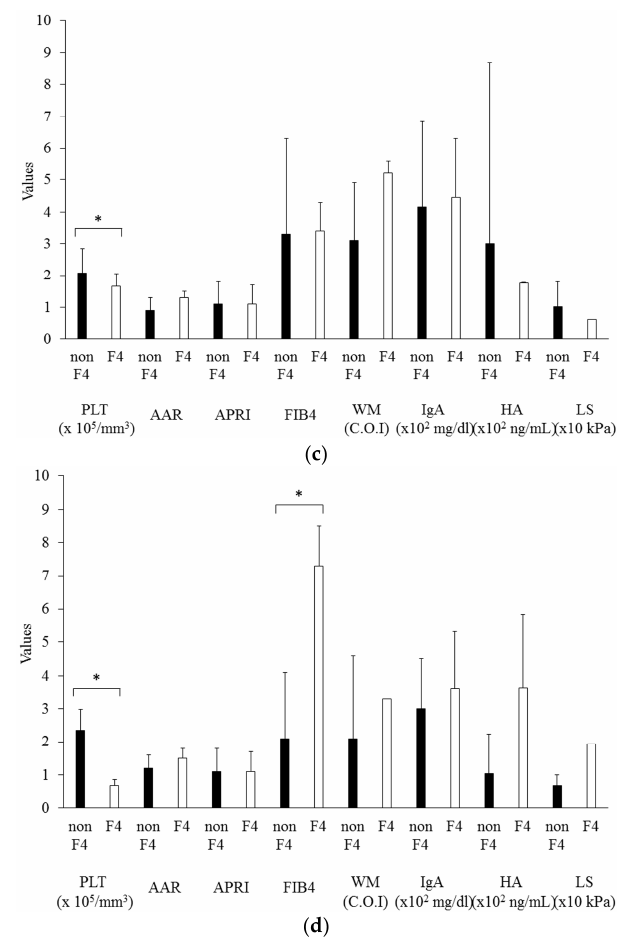
Figure 1. Non-invasive fibrotic markers in non-cirrhotic (non F4) patients and cirrhotic (F4) patients. ( a ) Total patients; ( b ) NASH patients; ( c ) AIH patients; ( d ) PBC patients. The bar graph represents the mean values, and the error bar represents standard deviation values. AAR, AST to ALT ratio; APRI, aspartate aminotransferase to platelet ratio index; FIB4, fibrosis index based on four factors; WM, Wisteria floribunda agglutinin-positive human Mac-2-binding protein; IgA, immunoglobulin A; HA, hyaluronic acid; LS, liver stiffness; * p < 0.05.